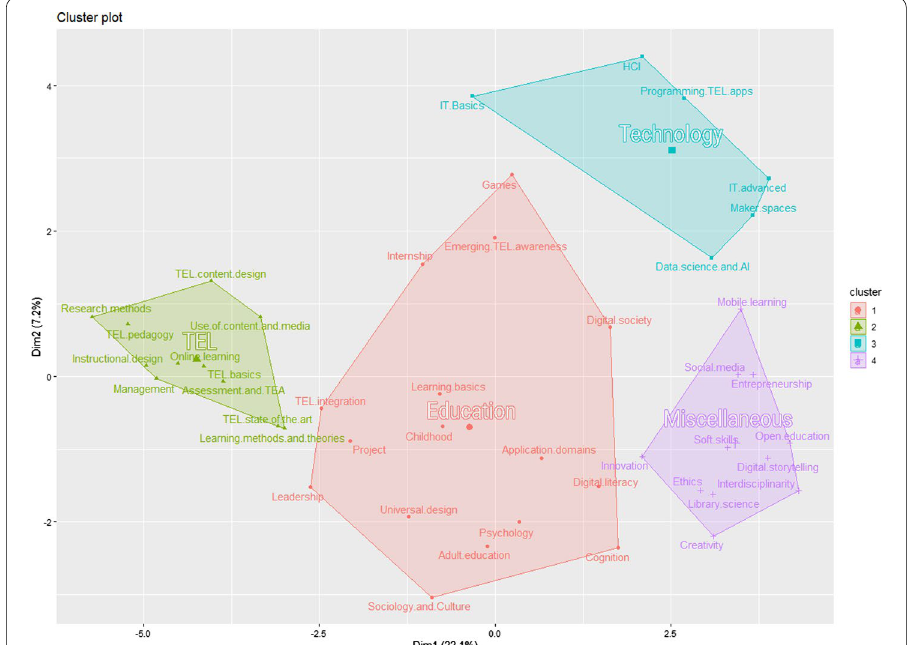
Fig. 7 Visualization of hierarchical cluster analysis of 44 curriculum topics identified in study programs on